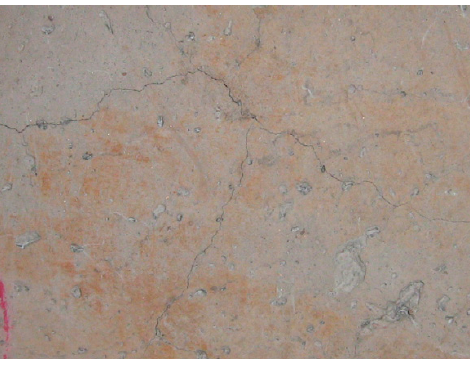
Figure 1. Pre-existing fractures on the surface of a block after heat and cooling treatments from Zhou et al. [16].